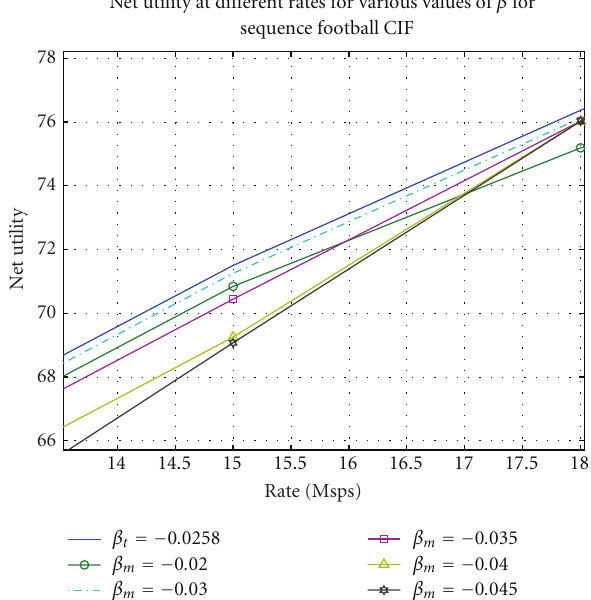
Figure 16: Net utility function versus rate at various values of parameter β for sequence football. CIF: β t = true value, and β m = misreprted